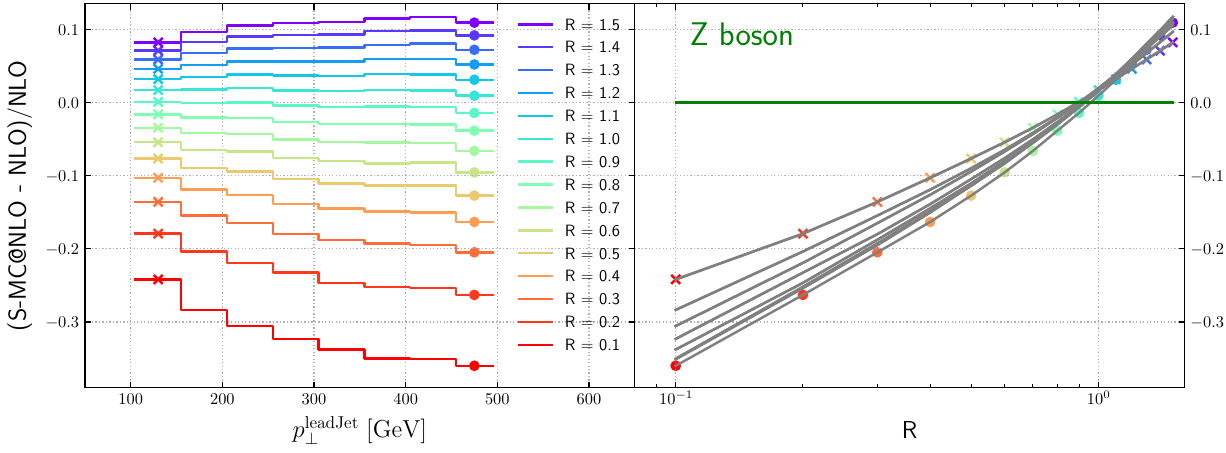
Fig. 15 Relative difference between the NLO-matched prediction and the fixed-order result as a function of the leading jet transverse momentum and the jet radius, for Z + ≥ 1